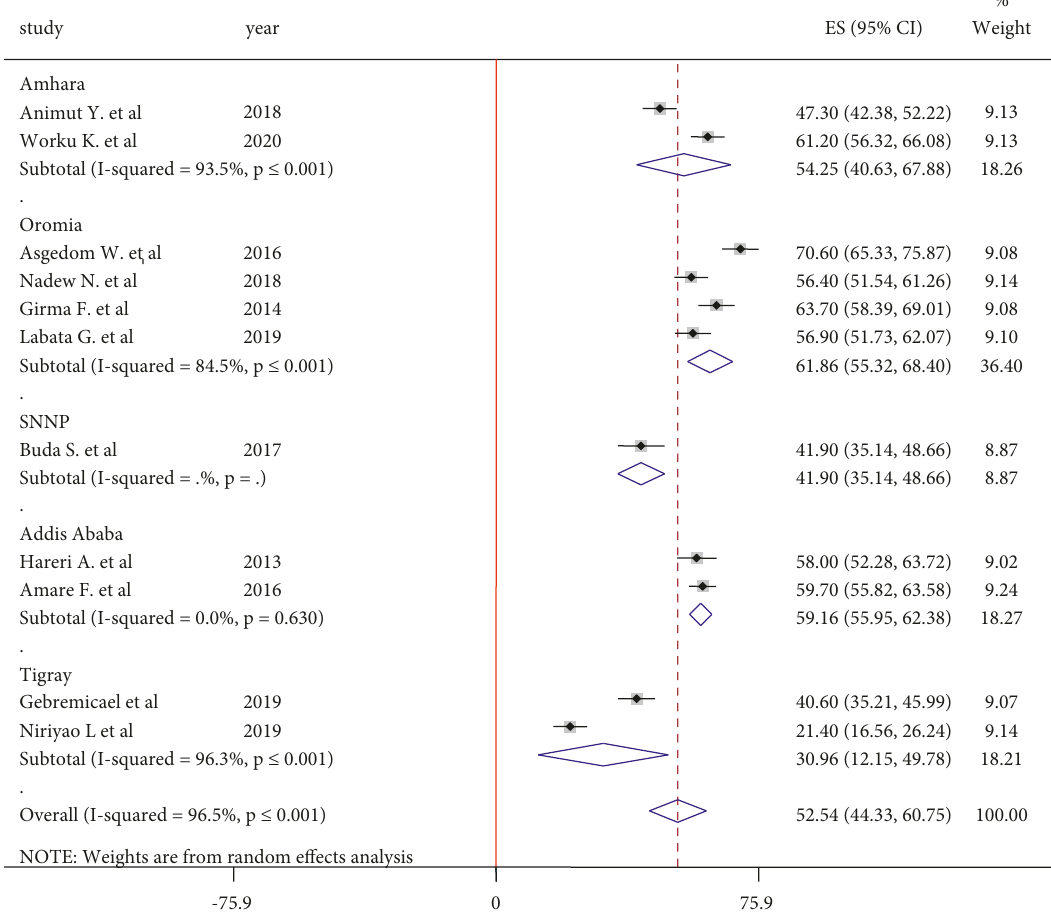
Figure 9: Forest plot on adherence to weight management among hypertensive patients in